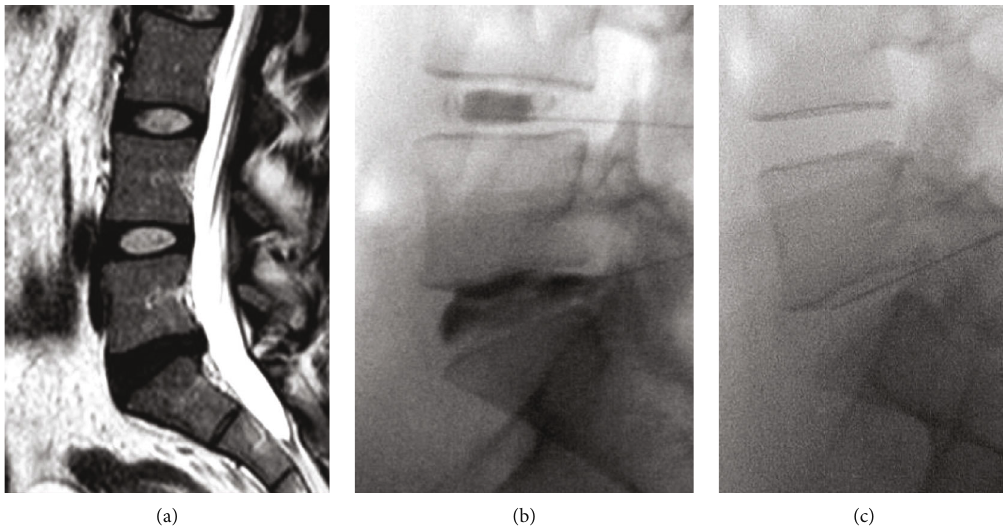
Figure 1: MRI showing disc desiccation at L5/S1 (a); discography showing abnormal dye pattern at L5/S1 (provoked concordant low back pain) and normal dye pattern at L4/5 (no pain provocation) (b); intradiscal BMAC injection at L5/S1